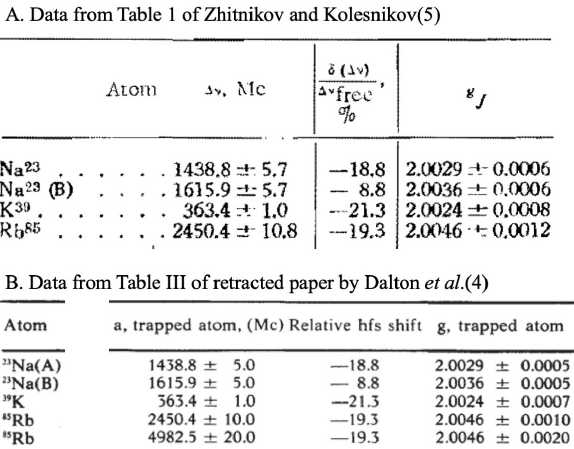
Figure 2: (A) Physical parameters reported in Zhitnikov and Kolesnikov 5 and (B) Dalton, et al. 4 Columns have been reordered for ease of